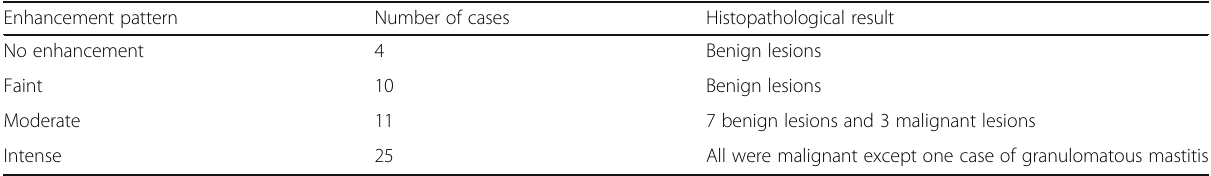
Table 3 The pattern of enhancement of lesions on CESM Enhancement